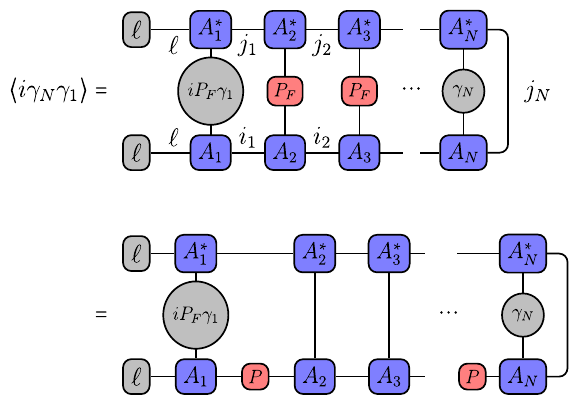
FIG. 9. Schematic representation of applying Eq. (B1) to fermionic operator γ 1, N